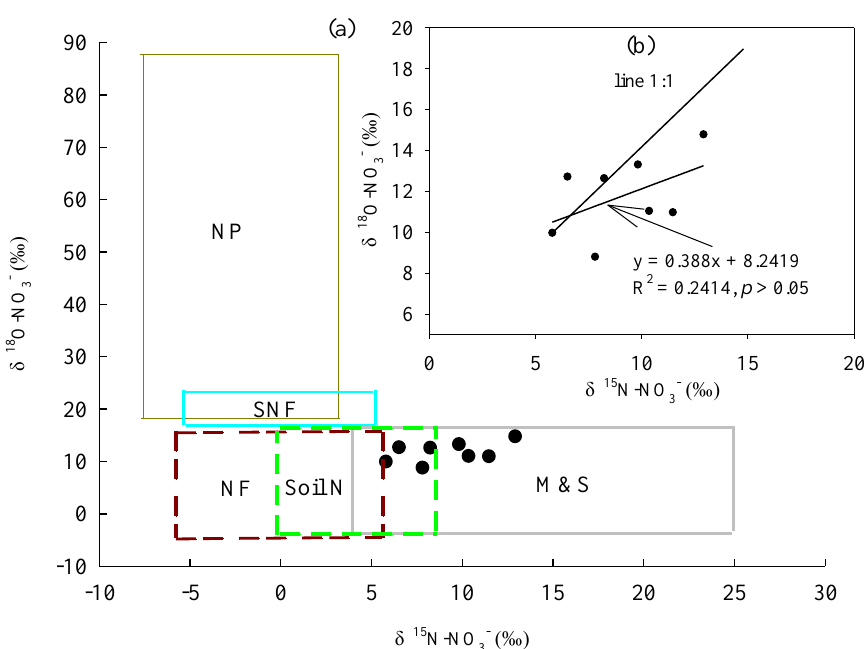
Figure 5. Range of δ 15 N-NO 3 − and δ 18 O-NO 3 − values present in seawater samples from the nearshore area of the north-eastern Beibu Gulf in the fall and various nitrate source reservoirs ( a ). The isotopic data of potential sources of nitrate including N fertiliser (NF), manure and sewage (M&S), and soil N are from Xue et al. [21]; and data on N in precipitation (NP) in northern South China Sea and synthetic N fertiliser (SNF) are from Yang et al. [22] and Silva et al. [59], respectively. The inset in the upper-hand right corner shows the relationship between δ 15 N-NO 3− and δ 18 O-NO 3− values in the nearshore area. Denitrification and/or N assimilation would cause the δ 15 N and δ 18 O values of nitrate to increase along a curve with a slope of 1:1 ( b ).